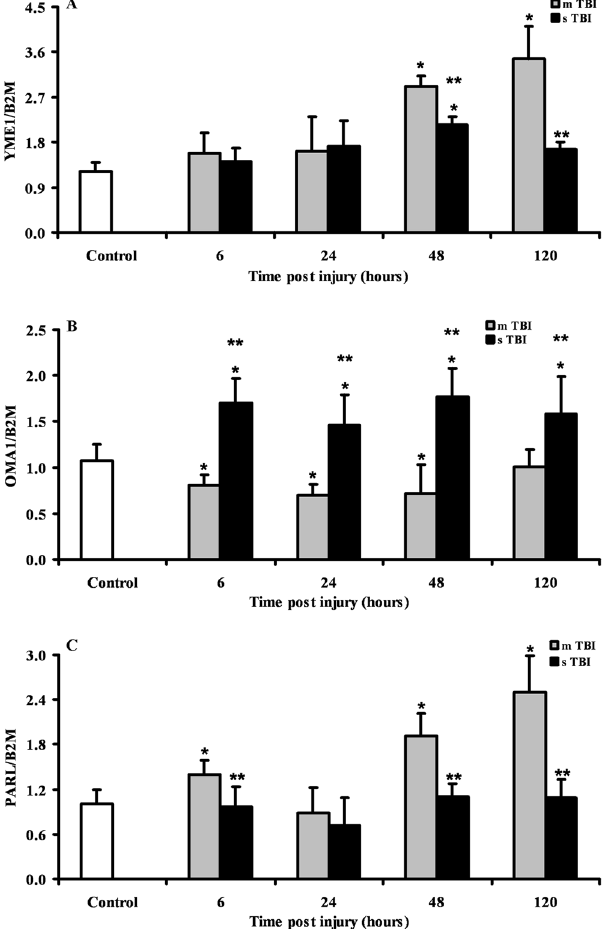
Figure 2. Changes in the expression of genes regulating the post-translational processing of OPA1 (YME1, OMA1 and PARL) in brain tissue homogenates of rats receiving TBI of graded severity (mTBI and sTBI) at different times post-impact. Values are the mean of 6 animals. Standard deviations are represented by vertical bars. Gene expressions were calculated relatively to the housekeeping gene β -2-microglobulin (B2M). * Significantly different from controls, p < 0.05. ** Significantly different from the corresponding time of mTBI rats, p <